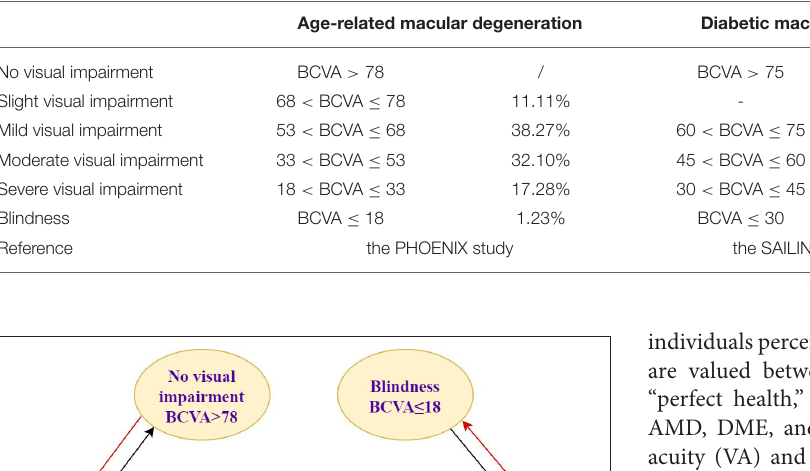
TABLE 1 | The health status classification and baseline visual acuity distribution.